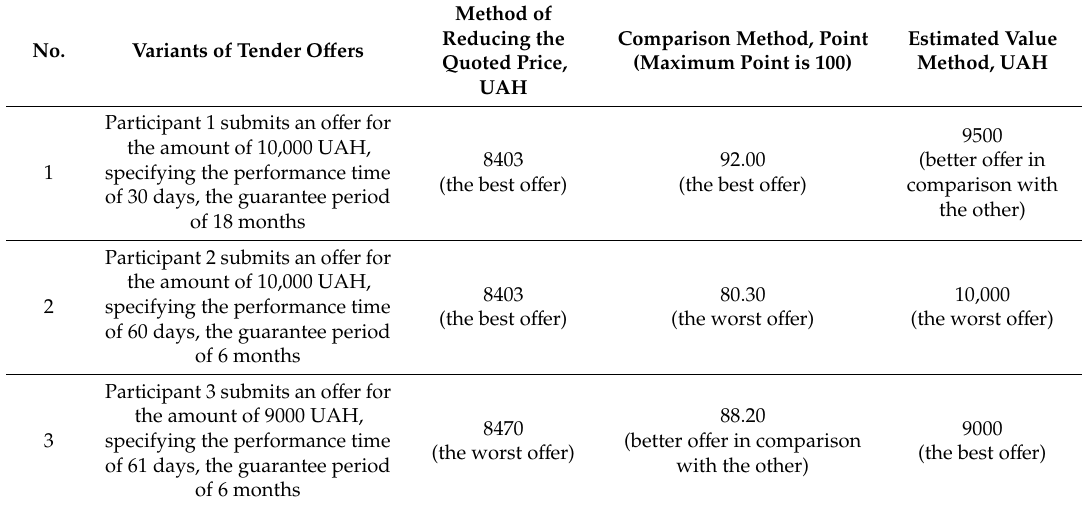
Table 7. Comparison of the results of the tender o ff ers evaluation by di ff erent